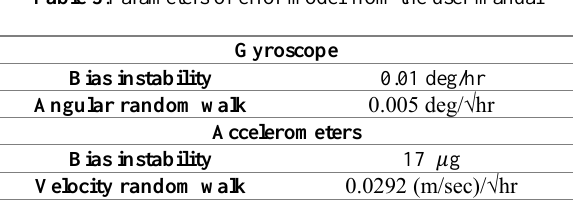
Table 4 .Parameters of error model from Allan variance